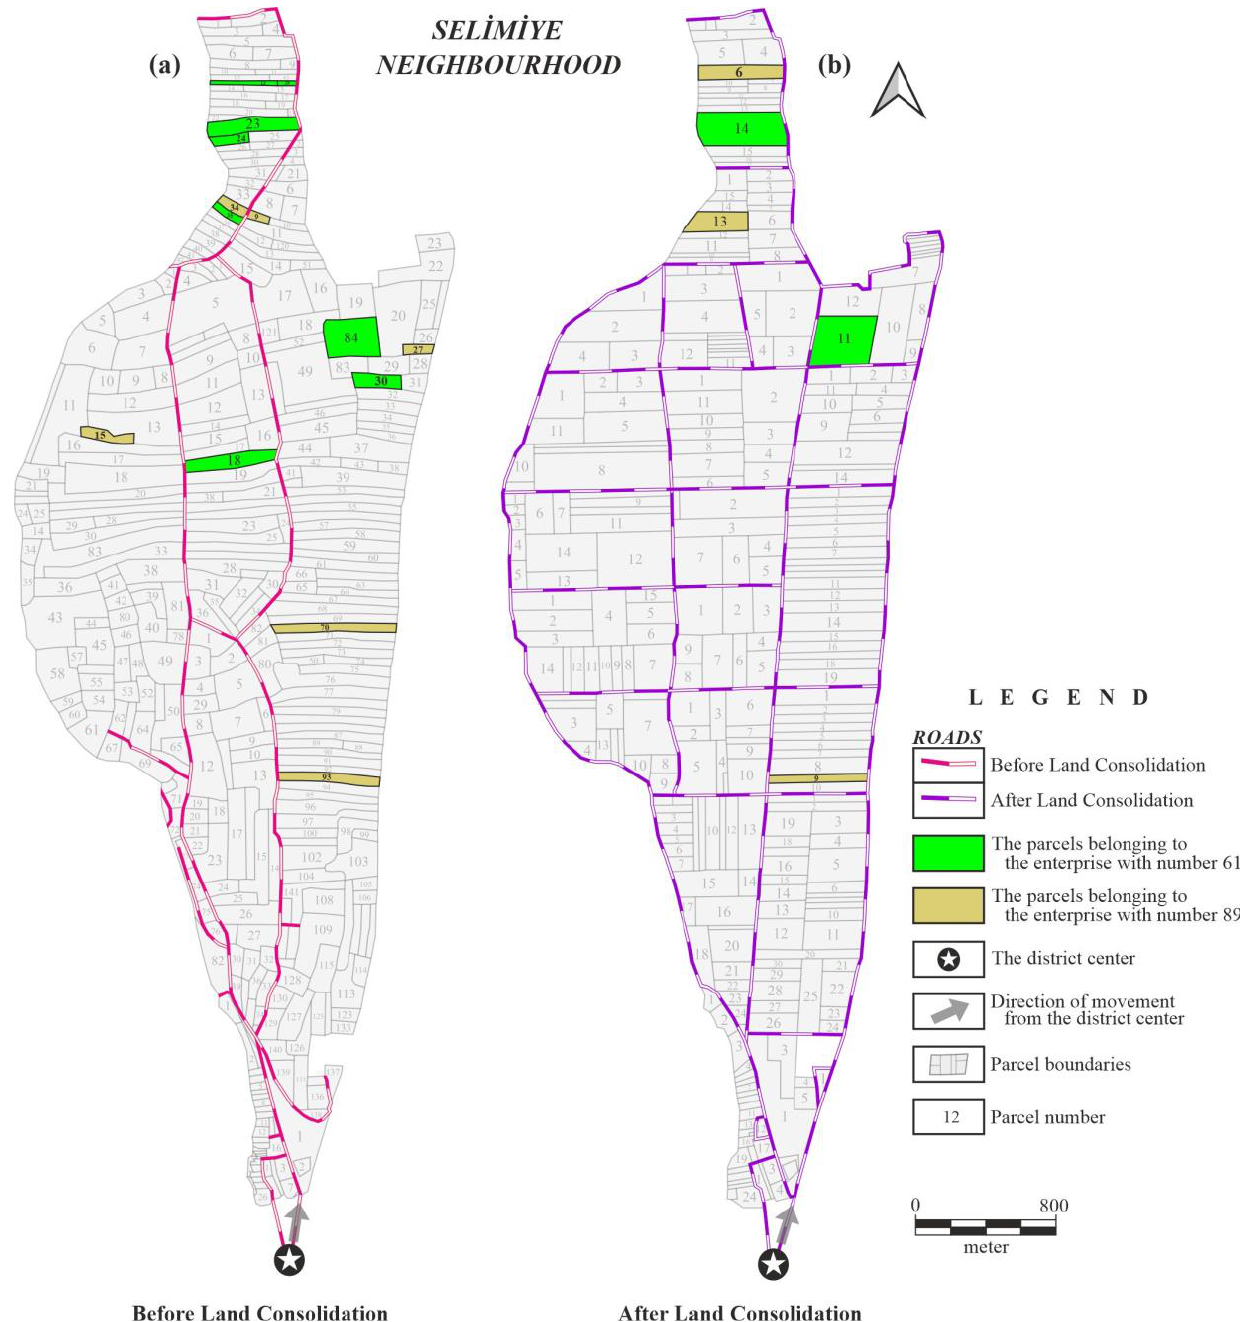
Figure 10. In the Selimiye Neighborhood: (a) routes followed by the enterprises with number 61 and number 89 to reach the field parcels before land consolidation; (b) route followed by the same and number 89 to reach the field parcels before land consolidation; ( b ) route followed by the same enterprises to reach the field parcels after land consolidation. enterprises to reach the field parcels after land